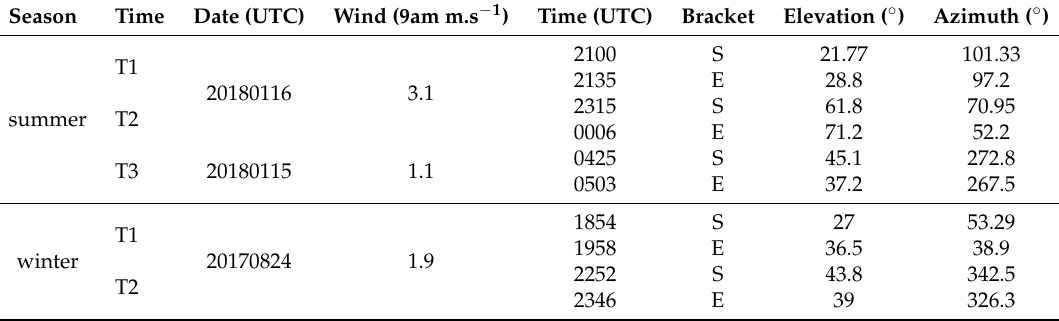
Table 1. Dates, times (UTC), sun azimuth, and elevation for first and last images collected in each survery. Start (S) and end (E) illumination conditions were calculated for a flat location at the latitude and longitude of the study site. Wind conditions were recorded in Lithgow, New South Wales, approximately 12 km away and at 300 m lower